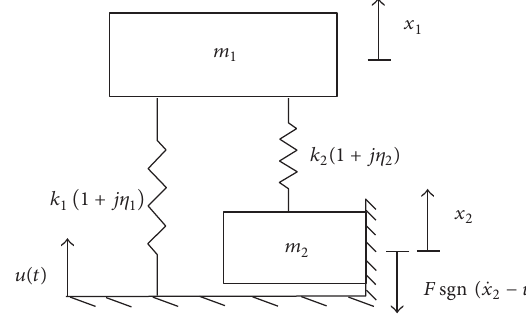
Figure 16: Two-degree-of-freedom model for comparison with T-beam